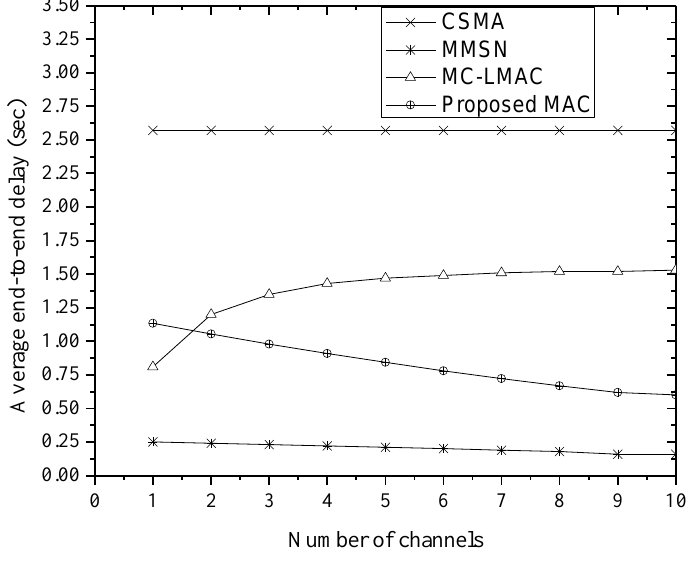
Figure 5. End-to-end packet delay with different number of channels.